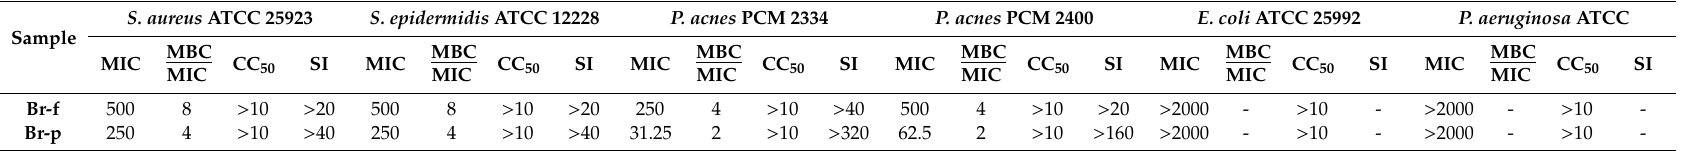
Table 1. Antibacterial activity (MIC, MBC / MIC ratio) and cytotoxicity (CC 50 as fibroblast activity and selectivity index SI) caused by burdock root samples.